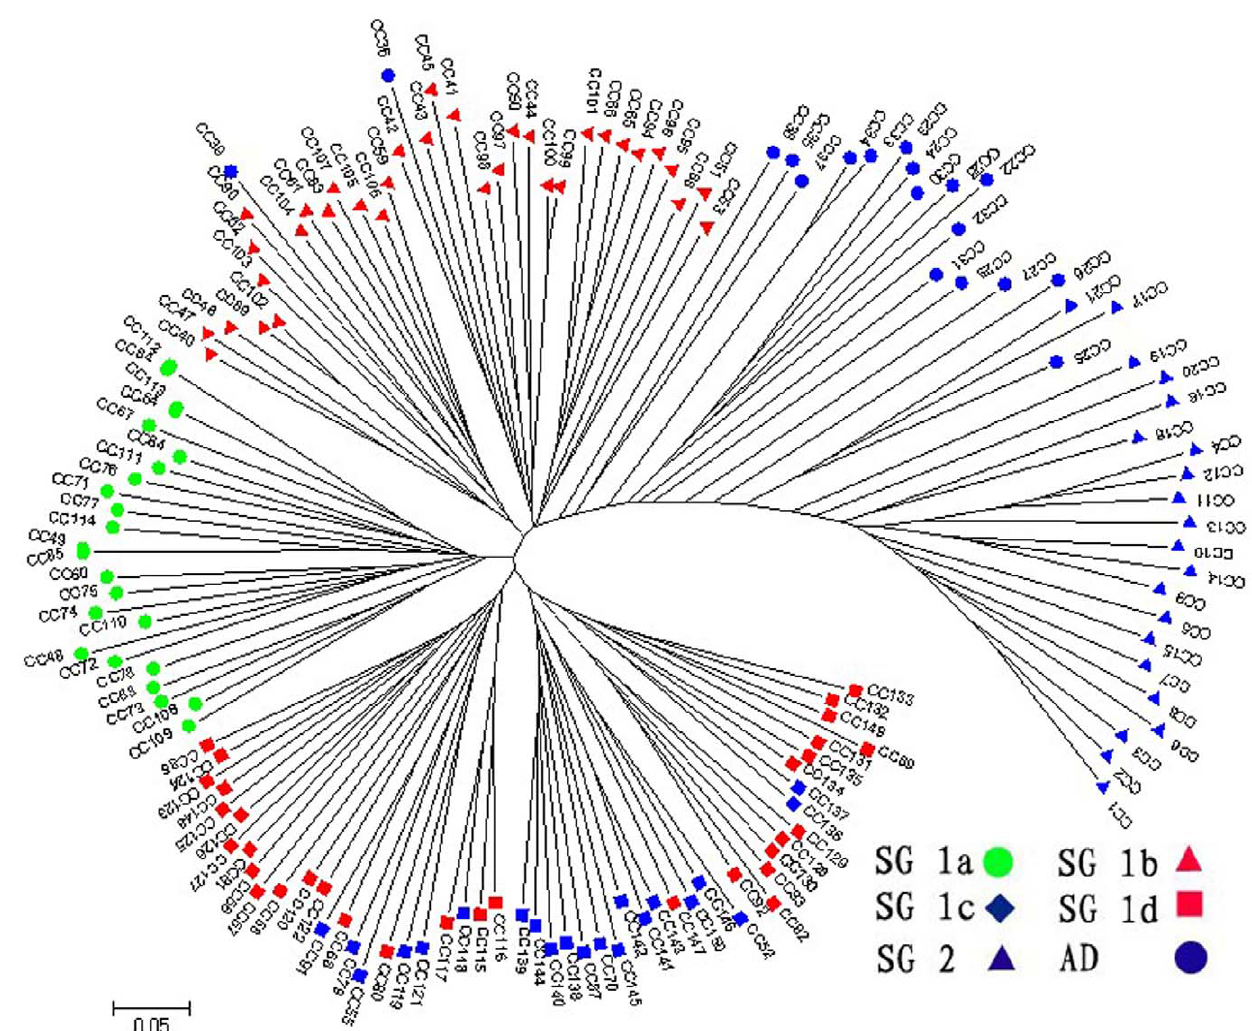
Figure 4. Unrooted neighbor-joining trees of 150 rice varieties in the core collection.